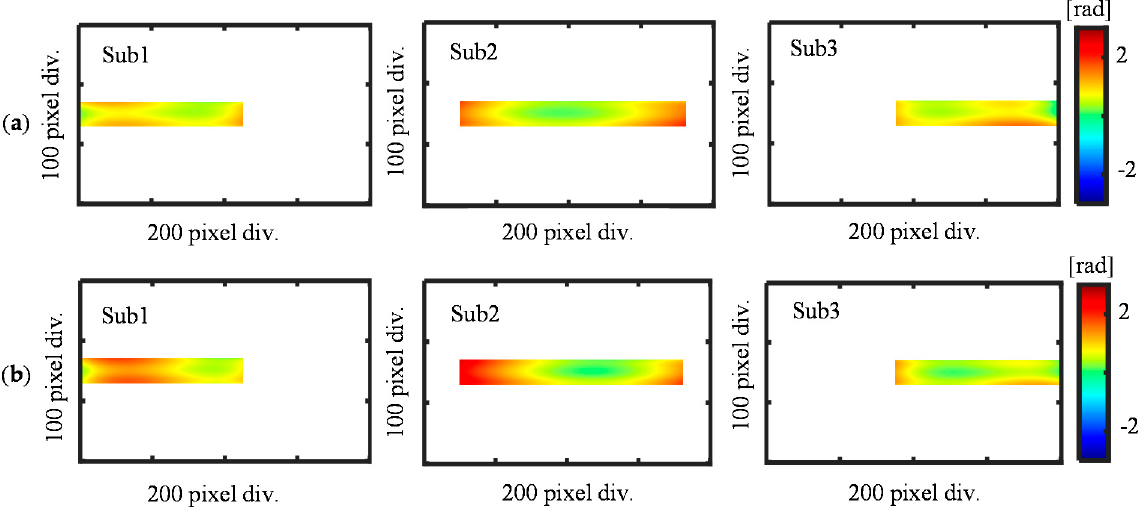
Figure 6. Simulation results of the positive and negative first-order diffracted beams. ( a ) Sub-apertures of the positive first-order diffracted beams; ( b ) Sub-apertures of the negative first-order diffracted beams.